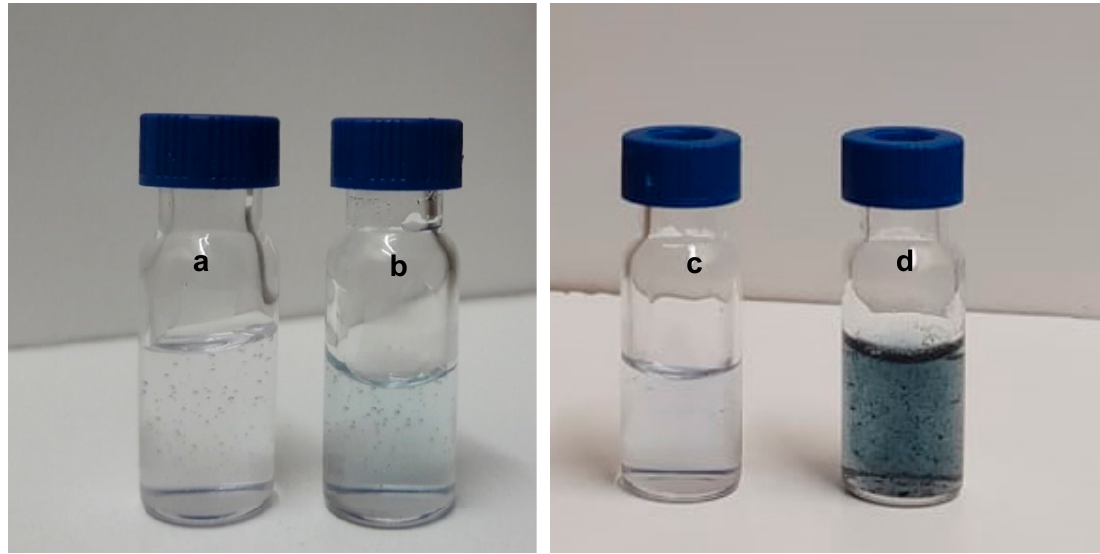
Figure 1. Images of the formulations ( a ) pure HA hydrogel, ( b ) HA-GP hydrogel, ( c ) pure HA hydrogel and ( d ) HA-NSP nanosystem (nanospheres + hydrogel).